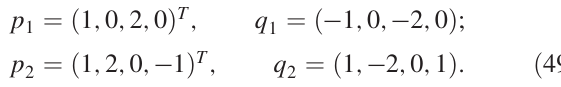
and f 1 are the charge ; 2 ; 2 toric code systems, respectively. p